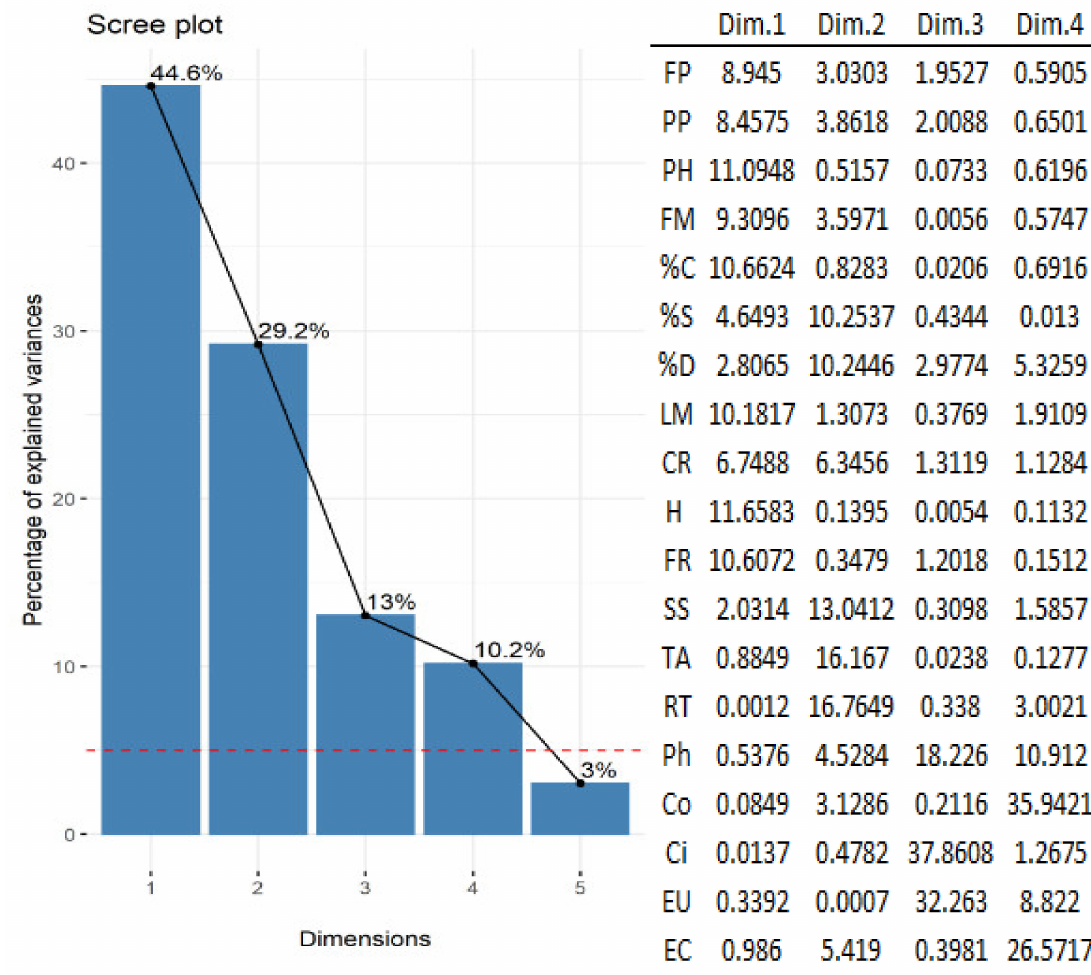
Figure 13. Decomposition of the main component analysis for the six different spacing (5, 10, 15, 20, 25, and 30 cm) in the production and quality of strawberry fruits cv. ‘Pircinque’. Caption: FP = fruits per plant. PP = production per plant. PH = productivity per hectare. FM = fresh mass. %CP = commercial percentage. %S= small fruits percentage. %D=discard percentage. LM = epidermis luminosity. CR = epidermis Chroma. H = epidermis hue angle. FR = firmness. SS = total soluble solids. TA = titratable acidity. RT = soluble solids/titratable acidity ratio. Cond = stomatal conductance. Ci = intercellular concentration. EU = water-use efficiency. EC = carboxylation